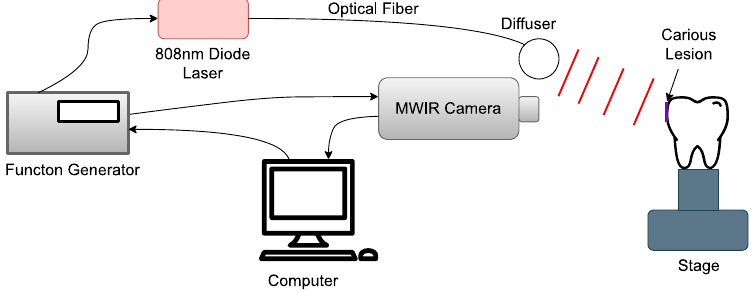
Figure 1. Block schematic of the thermophotonic imaging system: the bacteria-induced caries is highlighted by the purple rectangle and is positioned normal to the MWIR camera .